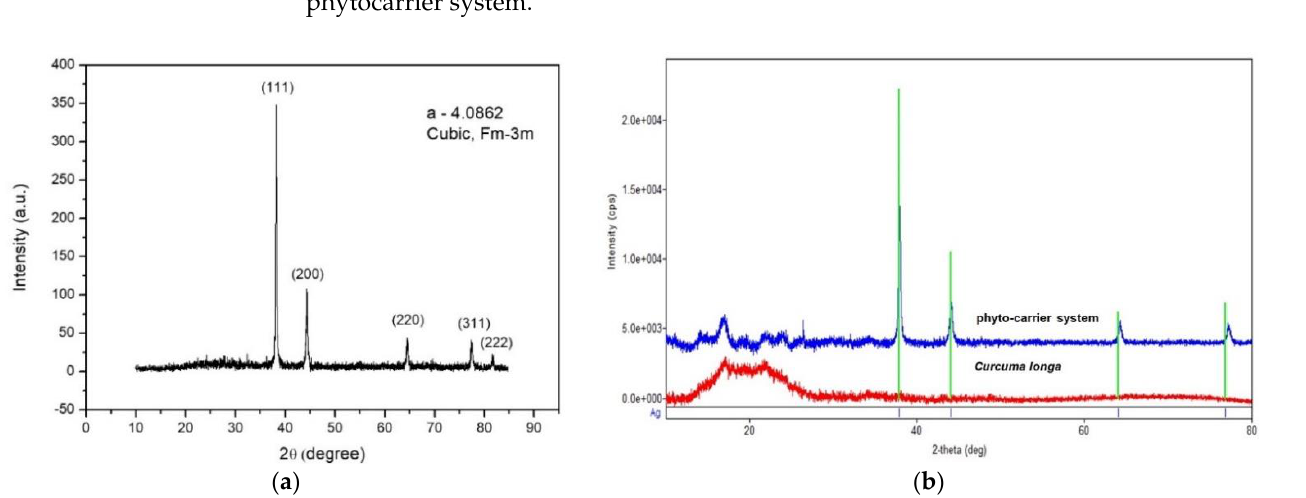
( b ) Figure 6. ( a ) UV-Vis spectra of citrate-coated AgNPs; ( b ) UV-Vis spectra of the phytocarrier system and curcuma sample. The sharp absorption maximum (λmax) at 417 nm ( Figure 6a) indicates that the size of the synthesized AgNPs is in the 20 – 120 nm range and dispersed [13,145]. Additionally, a single surface plasmonic peak (SPP) in the UV-Vis spectra suggests that the AgNPs are mostly spherical [145,146]. The shape of the curcuma absorption spectrum (Figure 6b) showed a maximum ab- sorption band at a wavelength of 424.5 nm (attributed to curcuminoids) and a shoulder